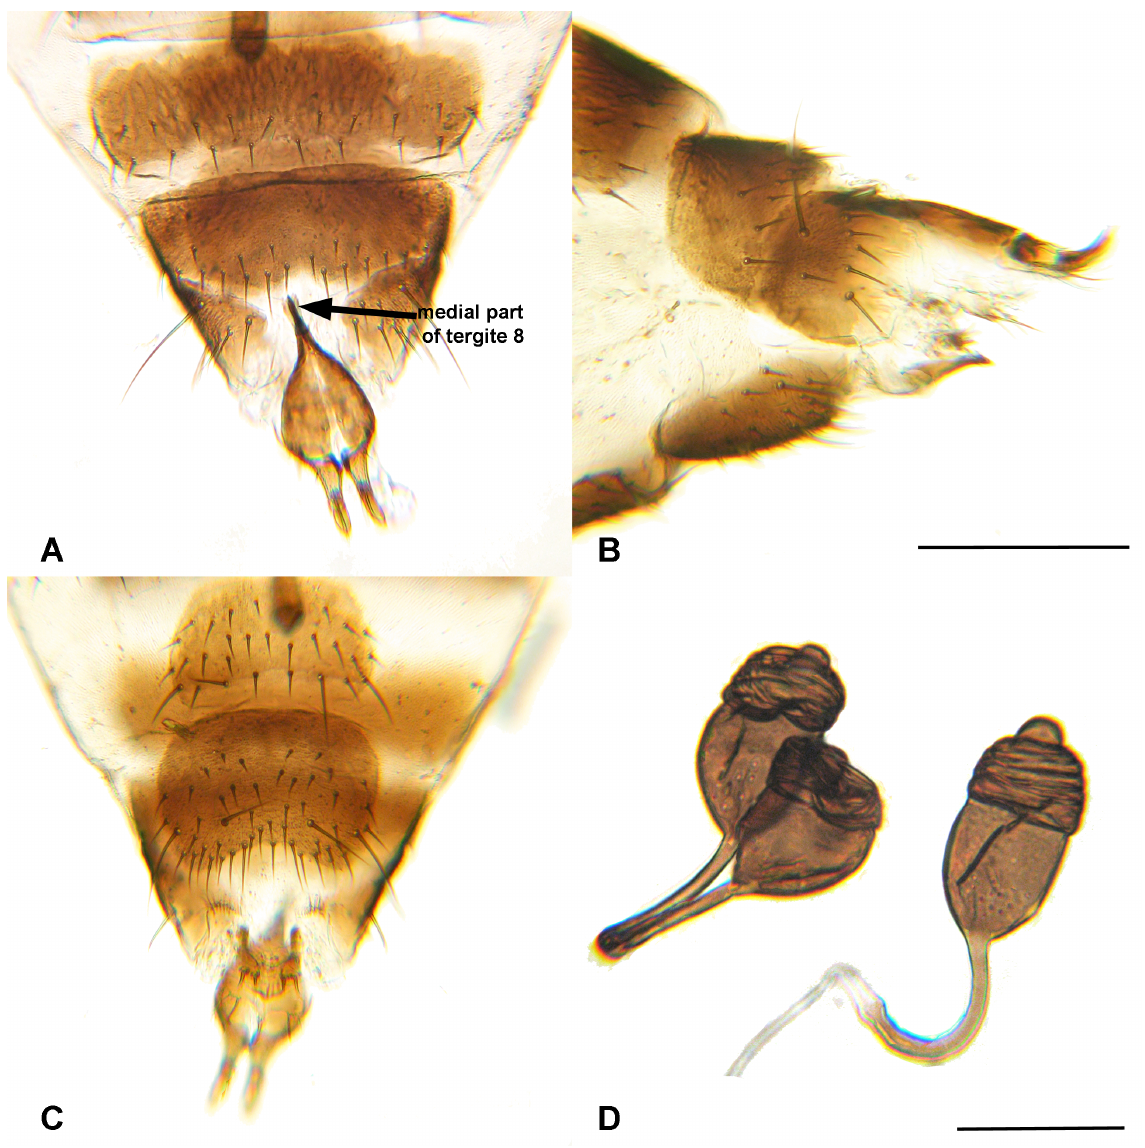
Fig. 17. Rudolfina pauca sp. nov., female terminalia (debu01086258). A . Terminal abdominal segments, dorsal view. B . Same as preceding, lateral view. C . Same as preceding, ventral view. D . Spermathecae. Scale bars: A–C = 0.20 mm; D =